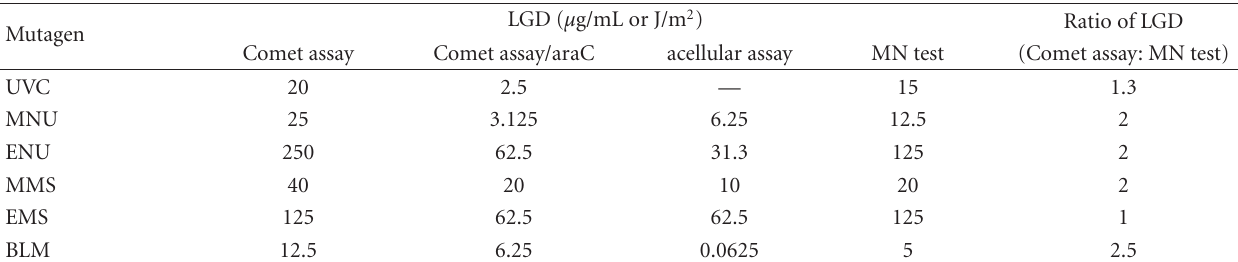
Figure 1: Comet assay and Comet assay/araC in TK6 cells. Slides for Comet assay were prepared immediately after the exposure to chemical mutagens for 2h with or without araC/HU, or 2h culture with or without araC/HU after UVC irradiation. Electrophoresis was conducted at pH > 13. Reproducibility was ascertained by three independent experiments, and representative data are shown. The error bars indicate standard errors of the mean. ∗ Significant di ff erence from untreated control: P < . 05. Table 1: LGDs for Comet assay, Comet assay/araC, acellular assay, and MN test using TK6